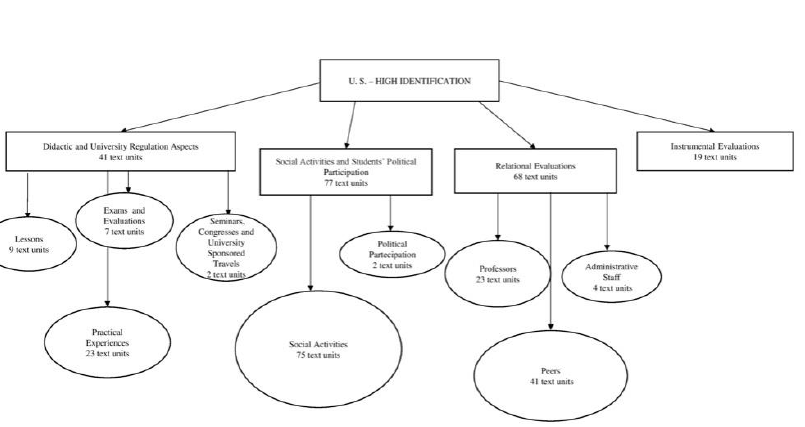
Concept map concerning U.S. students in the condition of high identification